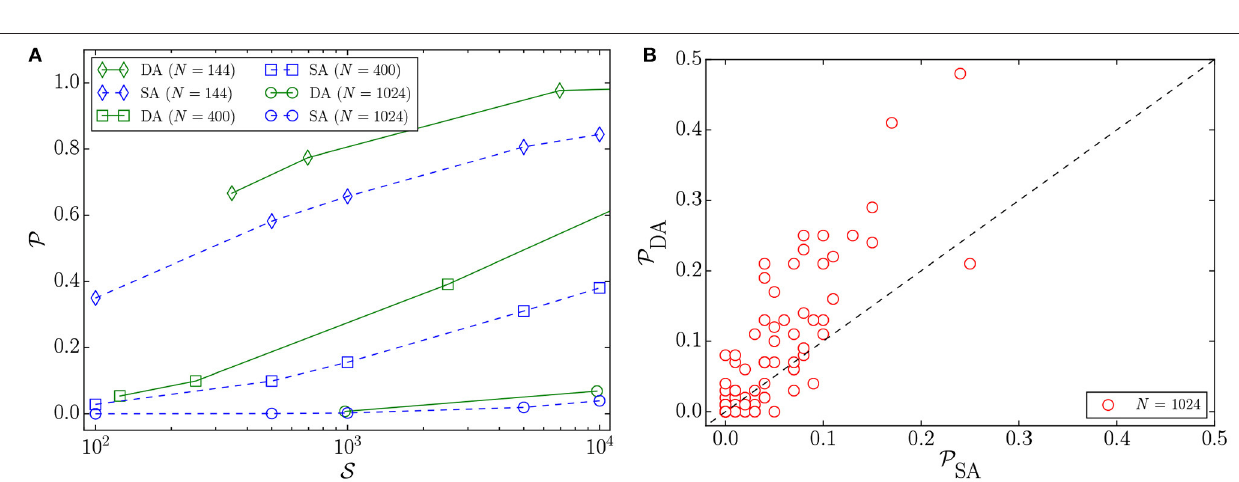
configuration without lowering the energy value (see section 3 for